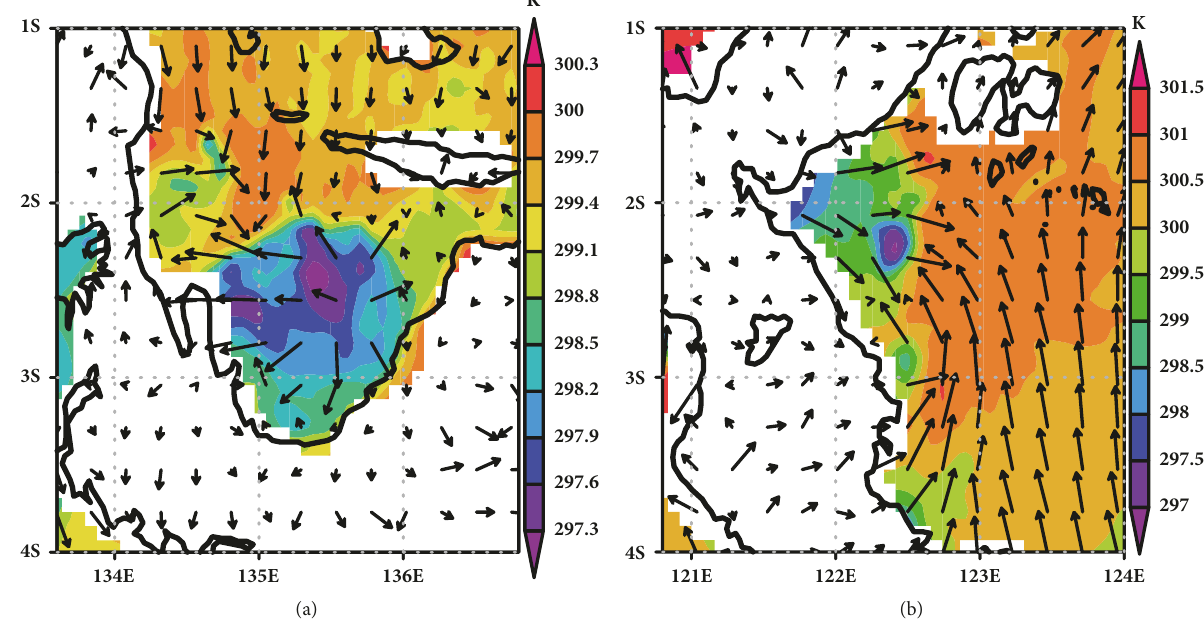
Figure 9: Surface potential temperature over (a) Cenderawasih Bay and (b) Tolo Bay. Lower temperature (K) is indicated as cold pool area.